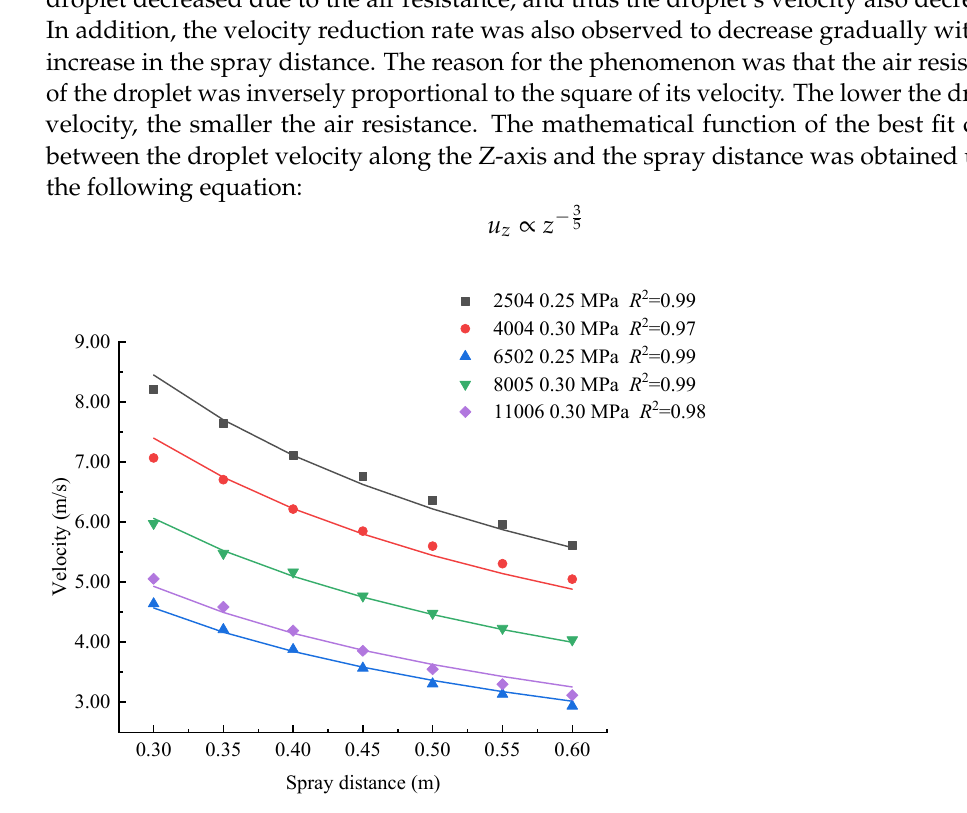
Figure 10. Fitting curves of droplet velocity vs. spray distance.